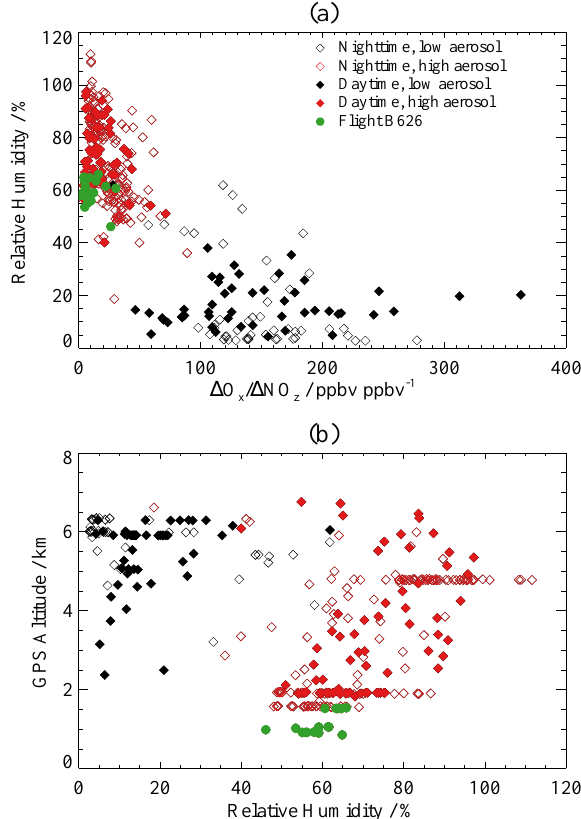
Fig. 10. Relationship between (a) relative humidity in percent and the ratio of the ∆ O x / ∆ NO z ratio in units of ppbvppbv − 1 , and (b) relative humidity and aircraft GPS altitude in km measured in boreal biomass burning plumes over the course of the BORTAS measurement campaign. Symbols are the same as those described for Figure 8.